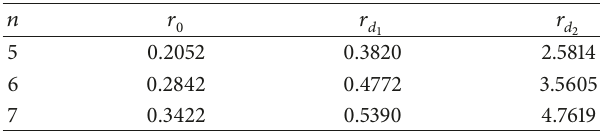
Table 1: Critical points of BD-BI theory for 𝑞 = 0.1 , Λ = −1 , 𝜔 = 10 , 𝑏 = 1 , and 𝛽 = 1.5